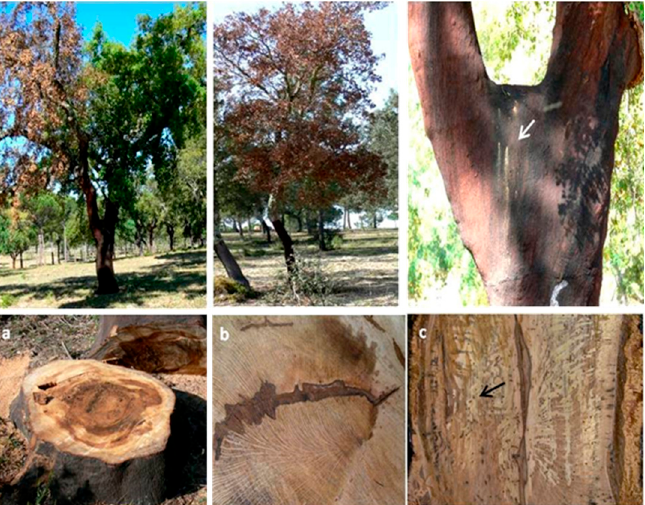
Figure 1. Symptoms on Quercus suber after the attack of Platypus cylindrus ; white arrowed, sign of the presence of P. cylindrus on the trunk: orange sawdust coming out of the entry holes. Internal lesions caused by P. cylindrus in the trunk of Q. suber trees: ( a ) wood staining accompanying the galleries system ( b ) detail of a gallery section with surrounding wood staining brown ( c ) bore holes in cork oak heartwood in cross-section (black arrow).